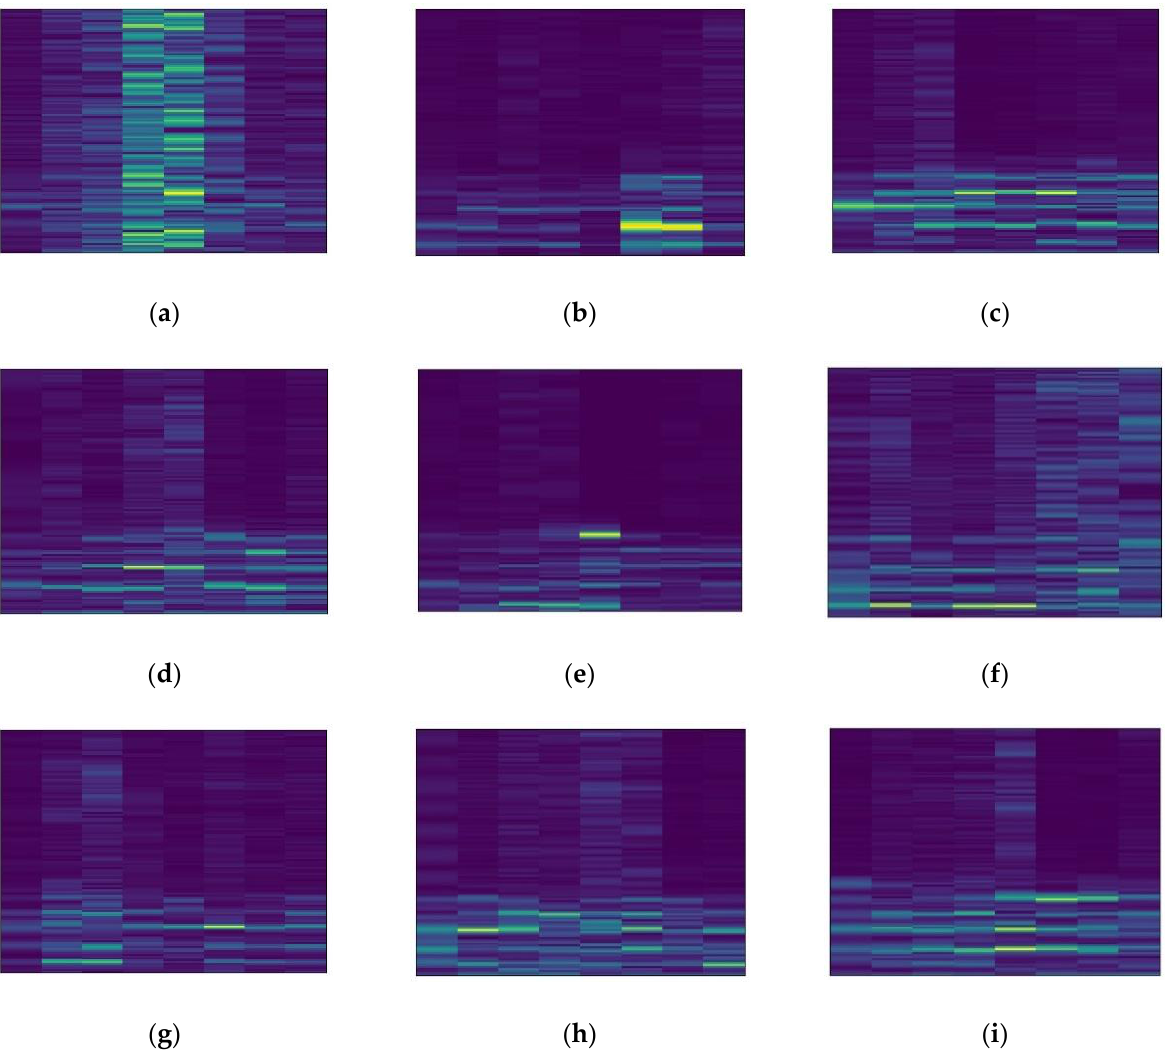
Figure 11. Spectrograms of 9 different labeled samples in domain A. ( a ) K001; ( b ) KA01; ( c ) KA03; ( d ) KA15; ( e ) KA16; ( f ) KI05; ( g ) KI07; ( h ) KI17; ( i ) KI18.